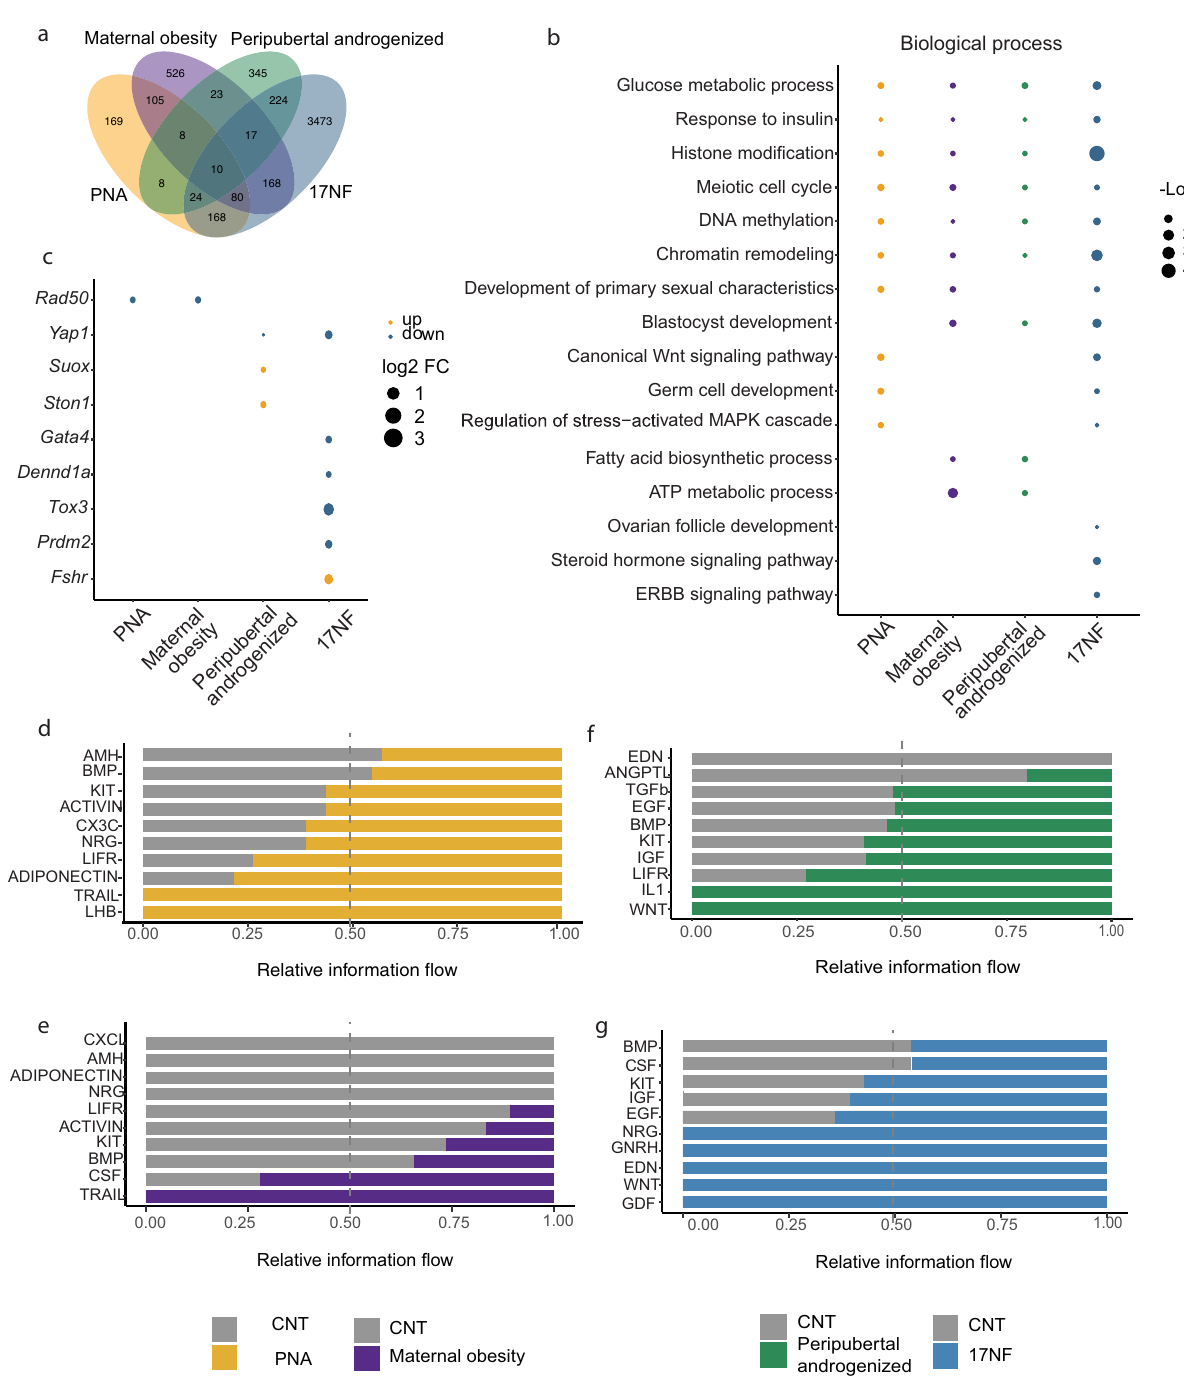
Fig. 4 Common and distinct transcriptomic signature of MII oocytes. a Venn diagram of DEGs of MII oocytes across all animal models (PNA model, n = 8/3 animals in control + vehicle, n = 10/2 animals in Prenatal DHT; maternal obesity, n = 8/3 animals in control, n = 15/3 animals in maternal obesity; peripubertal androgenized model, n = 56/8 animals in control + vehicle, n = 67/8 animals in peripubertal DHT; 17NF, n = 16/3 animals in control, n = 16/3 animals in 17NF). n = number of MII oocytes. b Comparison of enriched gene ontology term of DEGs in MII oocytes across all animal models. c Overlap DEG genes of MII oocytes with GWAS genes women with PCOS in PNA, maternal obesity, Peripubertal androgenized, and 17NF. d – g Signi fi cant signaling pathways were ranked based on their differences in overall information fl ow within the inferred networks between control and treatment group in PNA, maternal obesity, Peripubertal androgenized, and 17NF, also decreased (Fig. 5c, Supplementary Data 3). We also identi fi ed that the unique oxidative phosphorylation metabolism pathway is signi fi cantly upregulated in 17NF mice model (Fig. 5d, Supple- mentary Data 3).